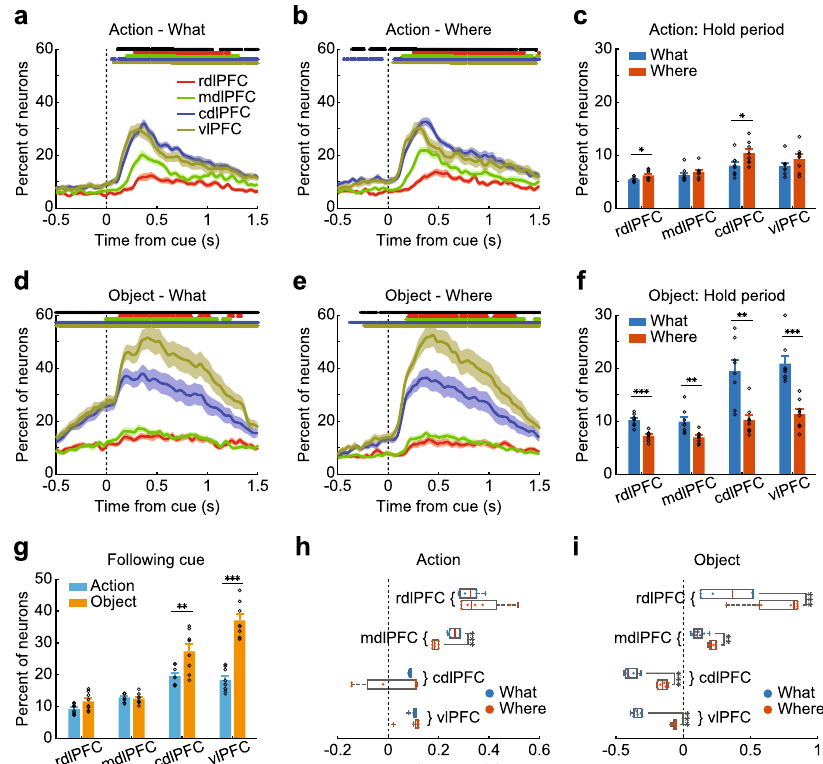
Fig. 2 Population encoding of chosen action and object. a , b , d , e Percentage of task-related neurons in each region that encoded actions in What ( a ) or Where blocks ( b ), encoded object identity in What ( d ) or Where ( e ) blocks. c , f The average percentage of task-related neurons in each region during the initial hold period, encoding action ( c ) or object information ( f ). Hold period: − 0.5 to 0s from cue onset. g The percentage of task-related neurons in each region by domain type, averaged from 0 to 1.5s from cue onset. h , i The response latency of the neuronal populations in each region for encoding action ( h ) and object identity ( i ), split by block type. The solid circles represent the response latency of each session. Boxplot box indicates the fi rst and third quartile, the center line of the box indicates the median, and whisker lengths re fl ect the interquartile range multiplied by 1.5. Shaded zones and error bars represent mean±SEM, n = 8 for each line, bar, or box. A two-sided t test was used to compare two populations, * p <0.05, ** p <0.01, *** p <0.001. The black * symbols at the top of each panel indicate a signi fi cant difference among the four regions (one-way ANOVA, p <0.01). The colored * symbols indicate a signi fi cant difference (two ‐ sided paired t test, p <0.01) of task-related neuron percentage between the corresponding region and its baseline. Source data are provided as a Source Data fi